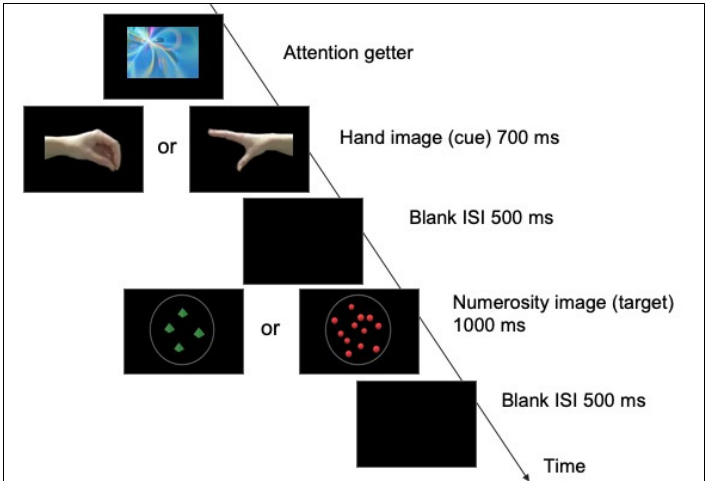
Figure 1. Schema of trial procedure: after the presentation of an attention getter, the hand image (cue) that depicted either an open or a close grip, oriented towards the left or right, was followed by a non-symbolic numerosity array containing either 4 or 12 elements. Congruent pairings were those in which an open grip was followed by an array of 12 and a close grip by an array of 4; the reverse association was considered an incongruent pairing.